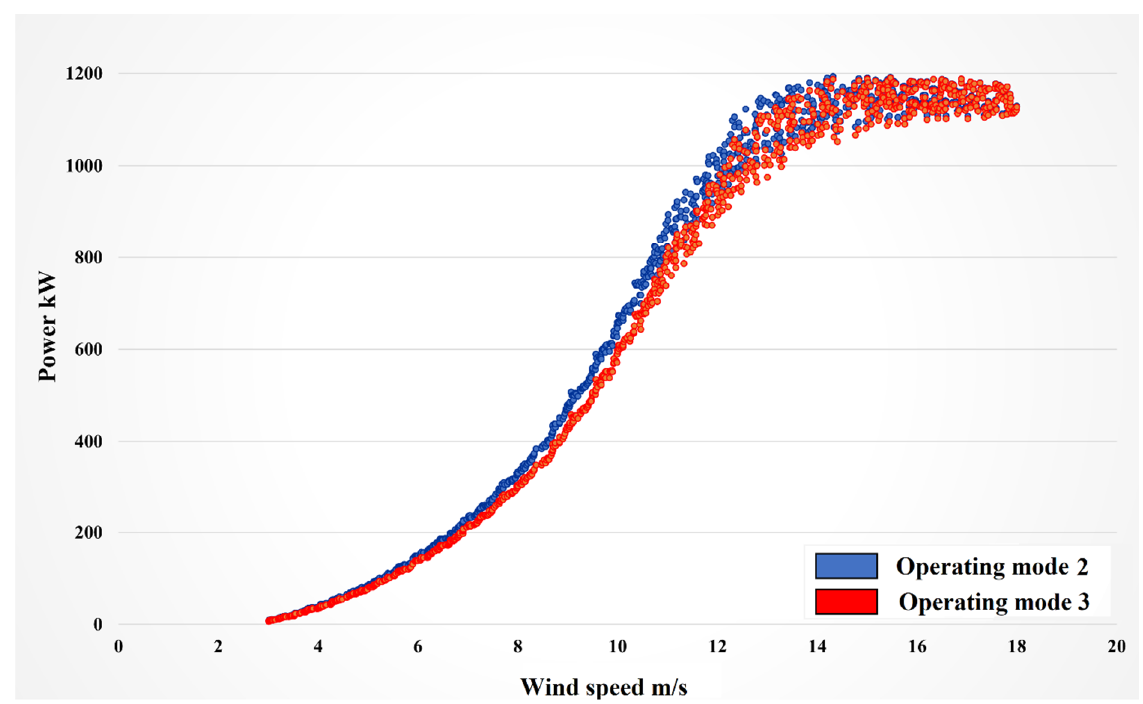
Figure 5. Power curve profiles of a generated measurements sample. Operating modes 2 and 3.